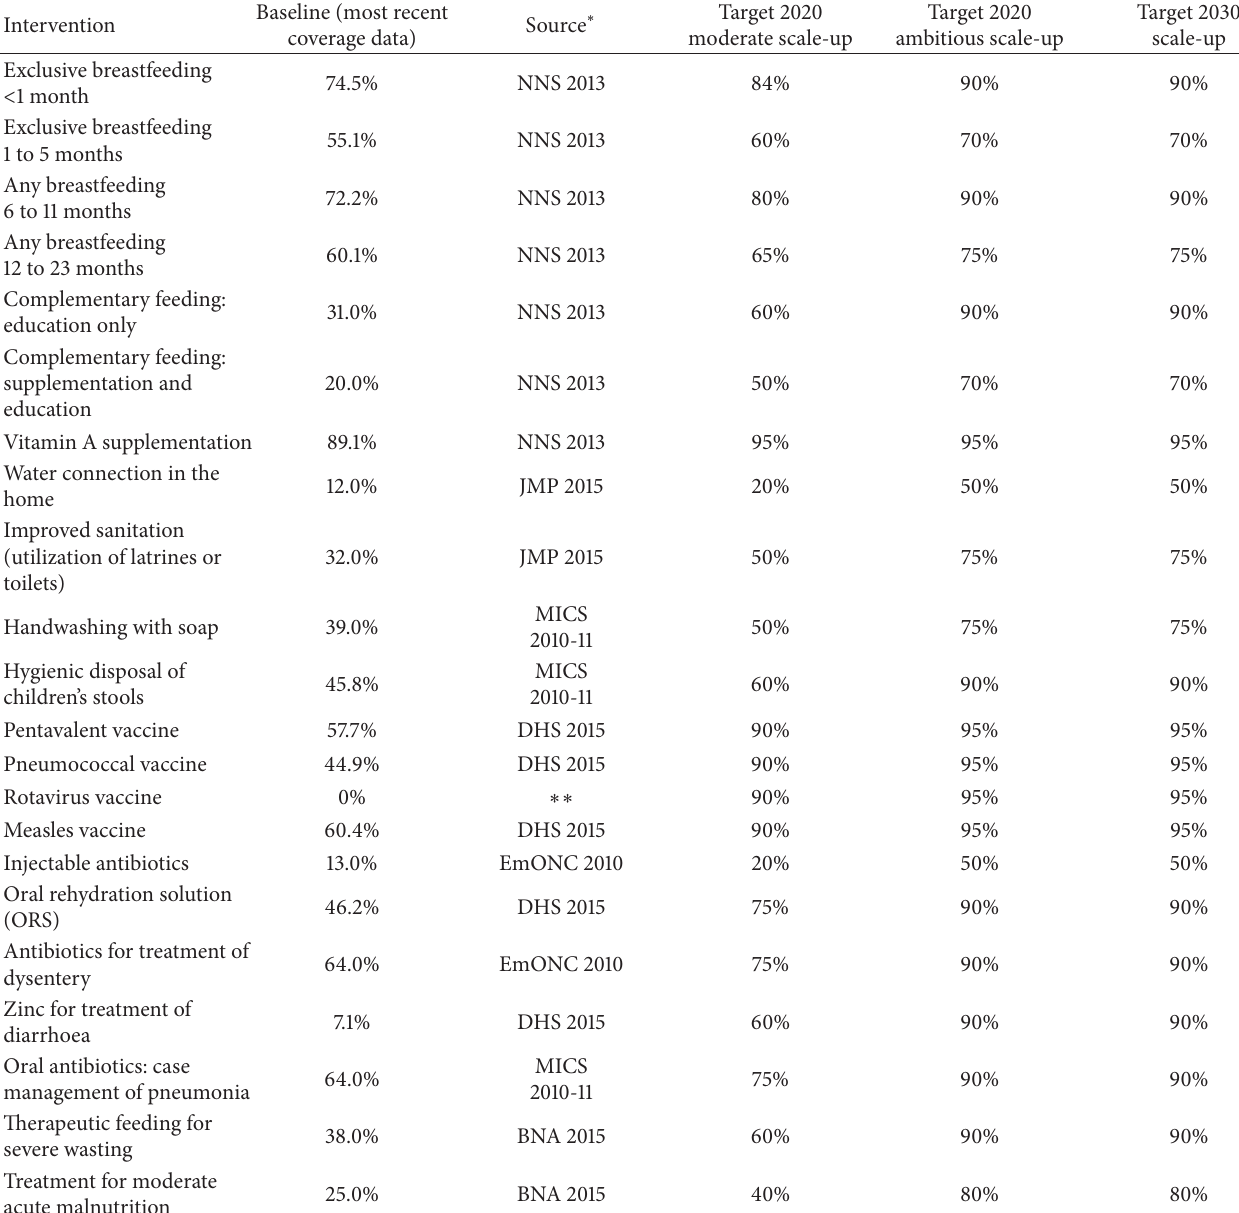
Table 1: Baseline and end line target coverage rates for interventions included in the Lives Saved Tool (LiST) modelled for scale-up scenarios.